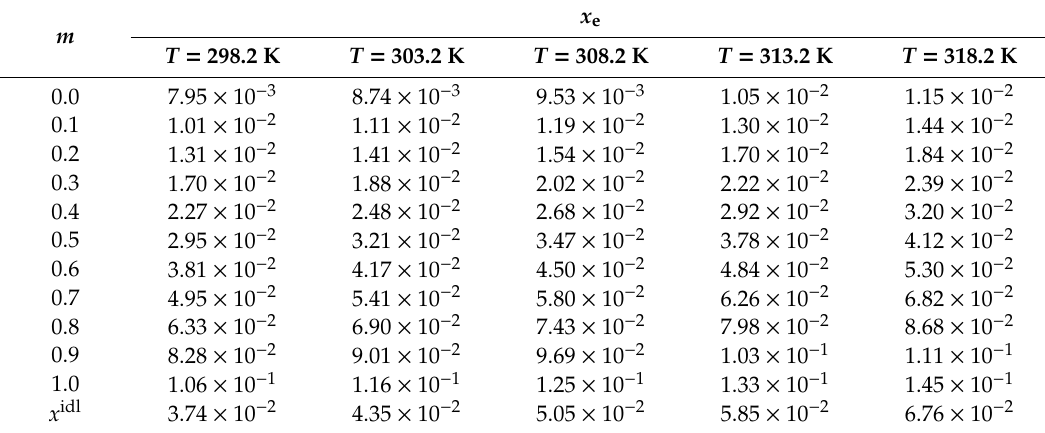
Table 1. Experimental solubilities ( x e ) of emtricitabine (ECT) in mole fraction in various “polyethylene glycol-400 (PEG-400) + water” mixtures ( m ) at “ T = 298.2 to 318.2 K” and “ p = 0.1 MPa” a .